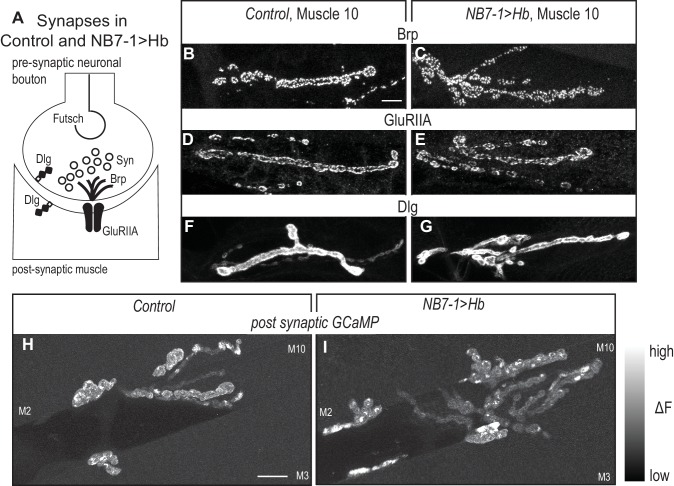
Altered synaptic arbors on dorsal muscles contain functional synapses.(A) Illustration of subcellular localization of neuromuscular synapse markers. Futsch labels microtubules; Synapsin (Syn) labels neurotransmitter filled synaptic vesicles; Brunchpilot (Brp) labels active zones; Glutamate Receptor IIA (GluRIIA) labels neurotransmitter receptors; Discs large (Dlg) is a scaffolding protein. (B–G) Images of neuromuscular synapses on L3 muscle 10. There is no difference in distribution or abundance of synaptic markers between Control (w1118) and NB7−1>Hb (NB7-1-GAL4/UASHb, UAS-Hb/+). (H–I) Images of fluorescence intensity changes in a calcium indicator of synaptic activity. GCaMP was targeted to the post-synaptic density for example (DLG in F-G). When pre-synaptic vesicles are released from active zones (Brp in B-C) post-synaptic neurotransmitter receptors respond (GluRIIA in D-E), increasing GCaMP fluorescence intensity (see Figure 6—figure supplement 1 for details). Images show post-synaptic responses (delta F) in L3 muscles 2, 3, and 10 (M2, M3, M10) in Control (NB7-1-GAL4/+; MHC-CD8-GCaMP6f-Sh/+) and NB7−1>Hb (NB7-1 GAL4/UAS Hb; MHC-CD8-GCaMP6f-Sh/UAS Hb) over a 5 min imaging period. All images are shown dorsal up, anterior to the left. Scale bar represents 10 microns.